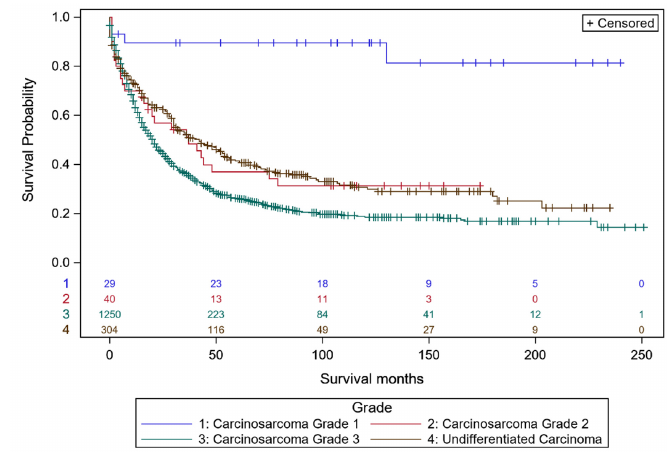
Figure 3. Kaplan–Meier ovarian cancer-specific survival showing number of women at risk according to grade of ovarian carcinosarcoma and undifferentiated carcinoma. Women with ovarian carcinosarcoma (8950/3, 8951/3 & 8980/3) that was grade 1 well differentiated (blue curve, n = 29; 50, 100 & 200-month survival is 89.1.0%, 89.1%, 81.7%), grade 2 moderately differentiated (red curve, n = 40; 50, 100 & 200-month survival is 37.7%, 31.9%, 31.9%), and grade 3 undifferentiated (green curve, n = 1250; 50, 100 & 200-month survival is 31.8%, 21.8%, 18.9%). Log-rank test p < 0.001. Women with undifferentiated EOC (8020/3) that was grade 3 by definition (black curve, n = 304; 50, 100 & 200-month survival is 46.9%, 32.9%, 25.8%).